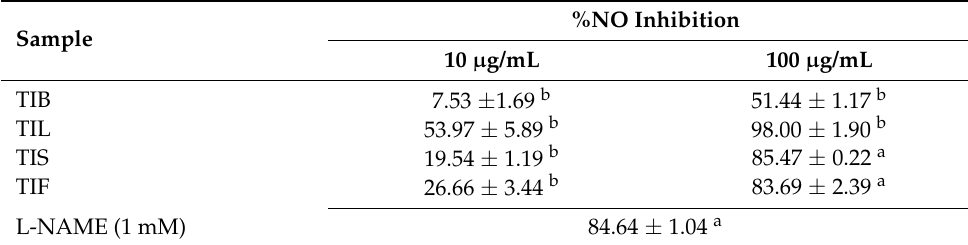
%NO Inhibition 10 µ g/mL 100 µ g/mL